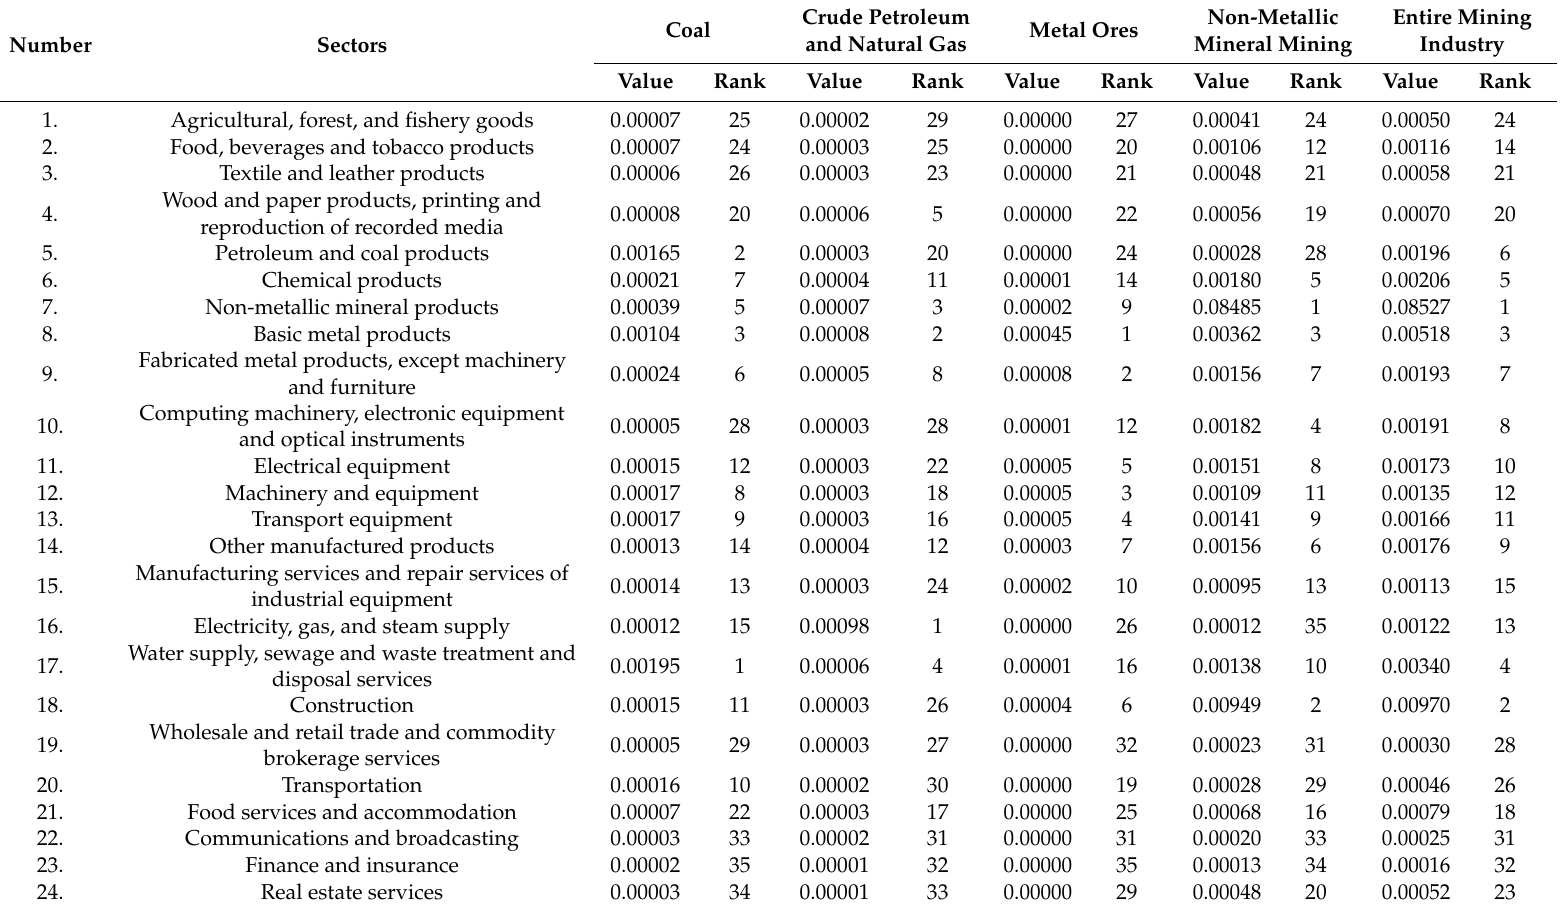
Table 6. Price-pervasive e ff ects of 10% increase in the price for the output of mining